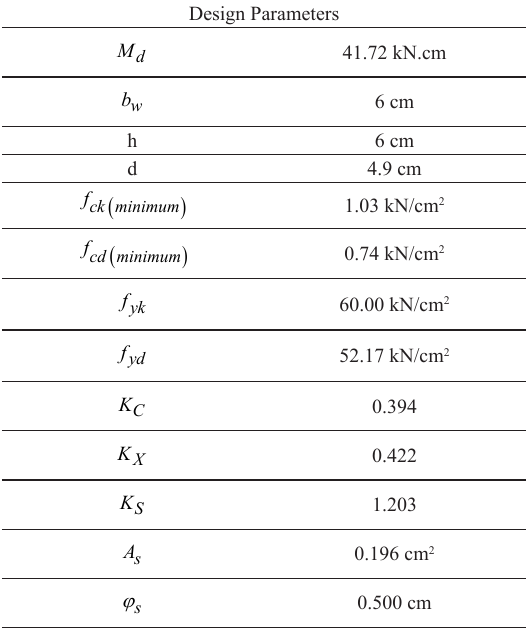
Table 1. Parameters obtained and used in the